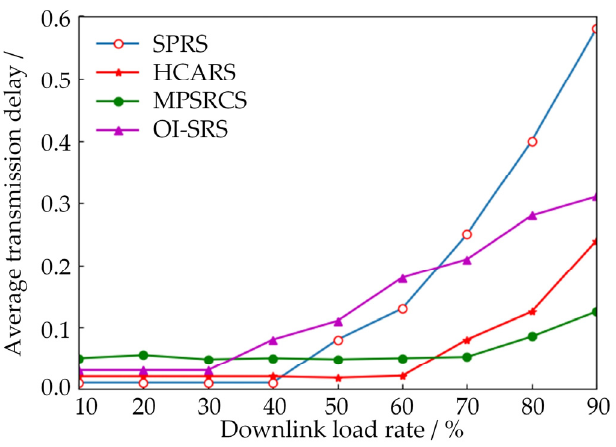
Figure 16. Comparison of the average transmission delay of LoRaWAN downlink